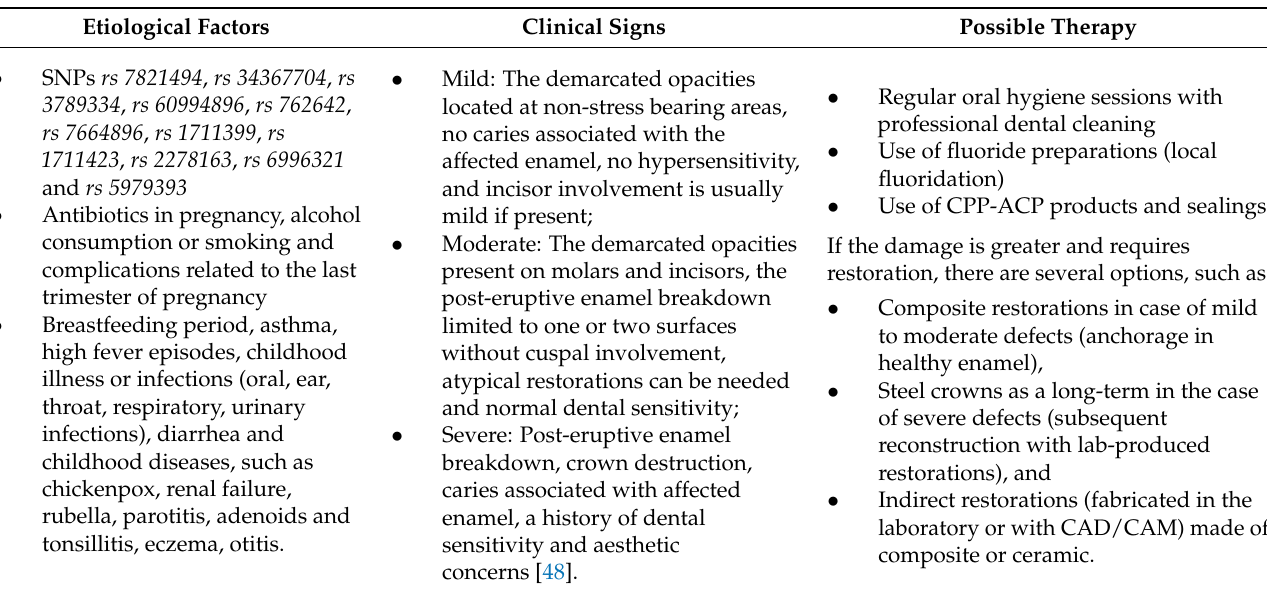
Table 1. Etiological factors, clinical signs, and possible